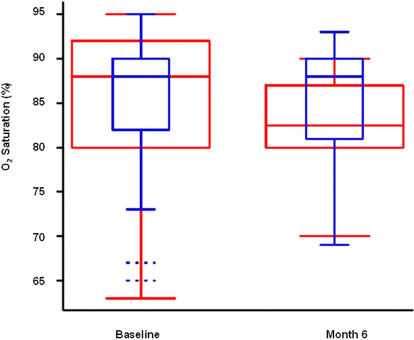
Distributions of oxygen saturation at rest at baseline and after 6 months follow-up.Box-and-whisker plots show the distributions for “rapid” progressors (red) and “slow” progressors (blue). Boxes indicating the middle 50% of data points extend from the first (25%) quartile to the third (75%) quartile. The height of each box is the interquartile range (IQR). The second (50%) quartile, or median, is indicated by a line within each box. Whiskers extend out to the smallest and largest data points within 1.5 IQRs of the first and third quartiles, respectively. Observations beyond the whiskers are potential outliers, indicated here by only two dashed lines, among slow progressors at baseline.